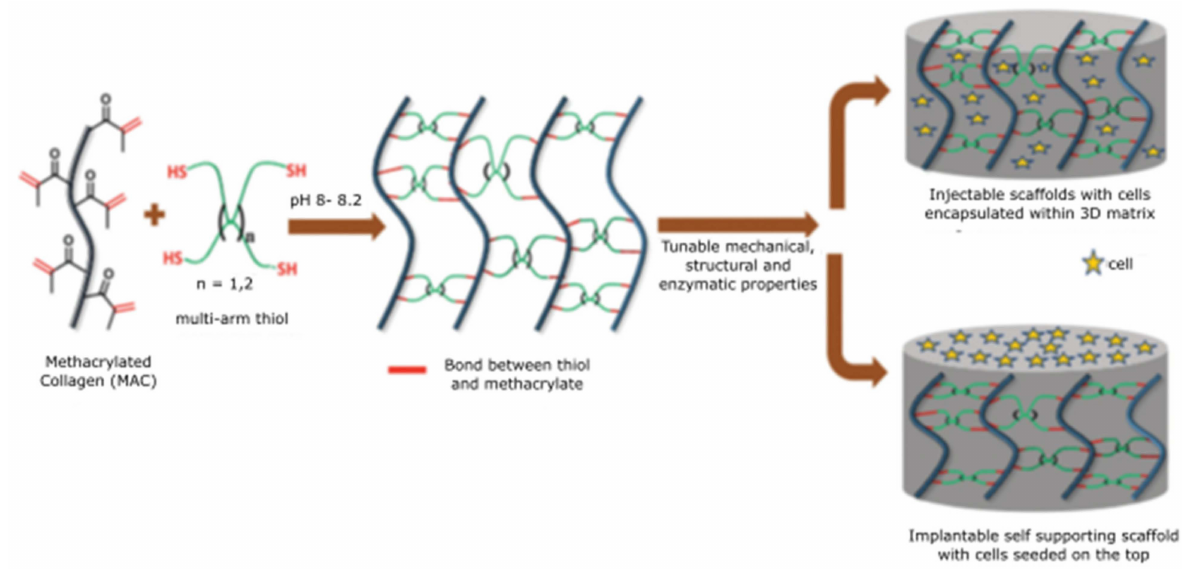
Figure 7. Schematic shows the fabrication of a methacrylated collagen (MAC) hydrogel cross-linked with PEG thiols (4- and 8-arms). (Reproduced with permission from [74] Copyright 2015, The Royal Society of